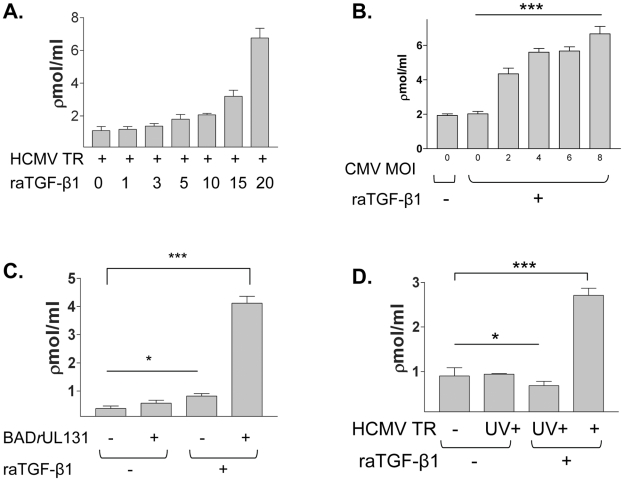
Effect of TGF-β1 and viral input upon TGF-β1 activation.(A) HK-2 cells were infected with HCMV strain TR at MOI of 1 and stimulated with increasing doses of raTGF-β1 from 1–20 ng/ml (0.04 nM–0.8 nM), washed, and assayed for de novo TGF-β1 production as described. HCMV infected HK-2 cells induced active TGF-β1 production in proportion to the amount of stimulating raTGF-β1. (B) HK-2 cells were infected with HCMV strain TR at increasing MOI (2-8) with raTGF-β1 stimulation at 15 ng/ml (0.6 nM), and luciferase bioassay performed to quantitate active TGF-β1 production. Active TGF-β1 production increased with increasing HCMV MOI. (C) HCMV AD169 strain BADrUL131 at MOI of 1 was used to infect HK-2 cells prior to raTGF-β1 stimulation, and TGF-β1 luciferase bioassay performed. Similar to results for HCMV strain TR, HCMV AD169 strain BADrUL131 induced active TGF-β1 production after EMT. (D) HCMV strain TR at MOI of 1 was inactivated by UV irradiation (HCMV TR UV+) and used to infect HK-2 cells prior to raTGF-β1 stimulation, and active TGF-β1 measured by luciferase bioassay. Irradiated virus failed to induce active TGF-β1 production after EMT. Legend: (*) p>0.05, ns; (***) p<0.01.